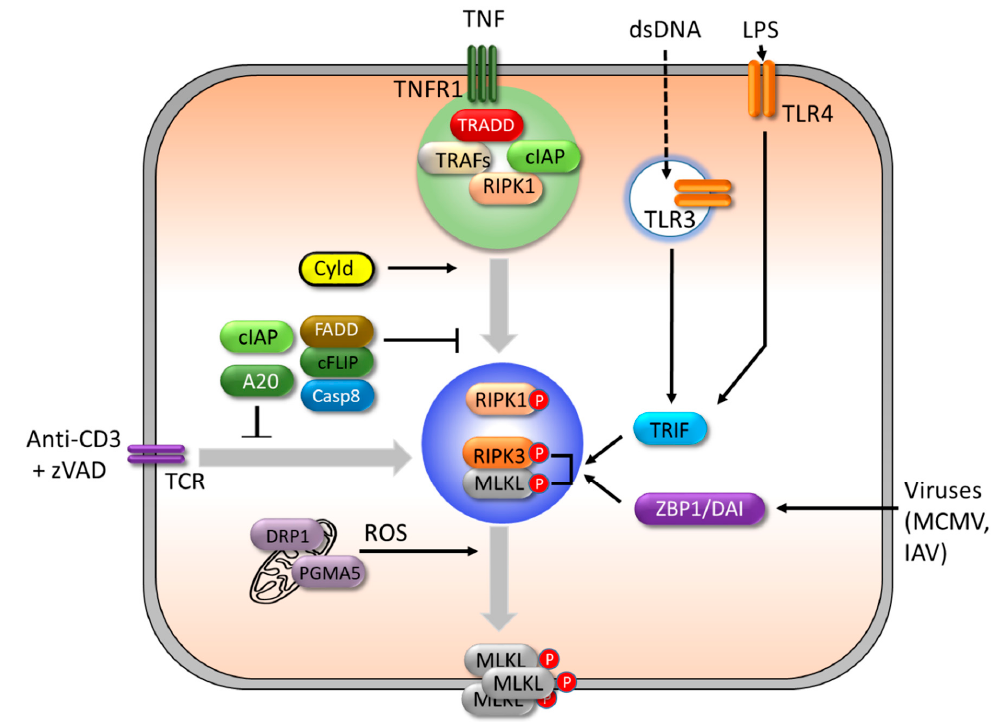
Figure 3. A simple depiction of the triggers and regulators of necroptosis. Upon TNF stimulation, cIAPs in the complex I inhibit necroptosis and execute cell survival signaling. Upon activation of TLRs by dsDNA, LPS, or viral infection, RIPK1-independent and RIPK3-mediated necroptosis is triggered by two RHIM-containing adaptor proteins, TRIF and ZBP1/DAI. T cell receptor triggering with caspase inhibitor (zVAD) also induces RIPK3-dependent necroptosis. The deubiquitination of RIPK1 by CYLD facilitates the formation of necrosome and promotes necroptosis. Another deubiquitinase, A20, also suppresses necroptosis through deubiquitinating RIPK1 or RIPK3. Phosphoglycerate mutase family member 5 (PGAM5) and Dynamin related protein 1 (Drp1) induce reactive oxygen species (ROS) production in the mitochondria and contribute to plasma membrane rupture.